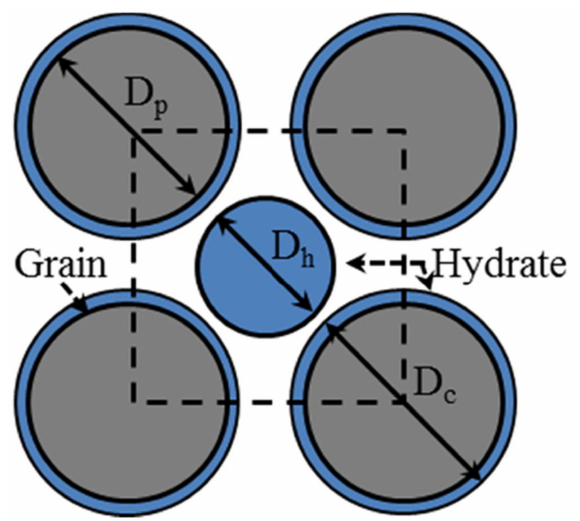
Figure 20. Representative elementary volume (REV) of hydrate-bearing porous media with the coex- istence of pore-filling and grain-coating hydrate reprinted from [62] with permission from